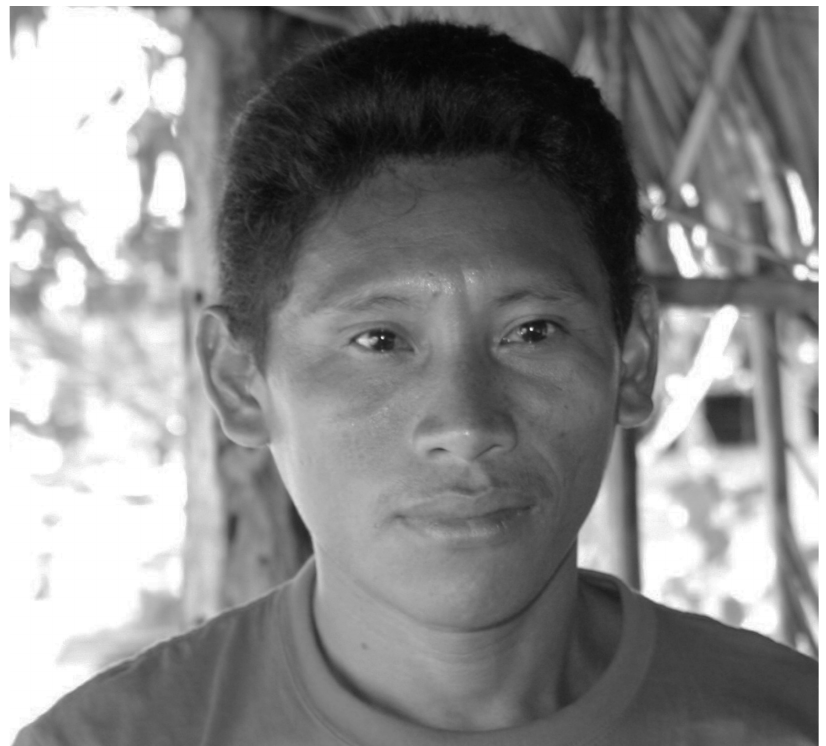
Figure 2. Wilmer Torres tells the story of losing two of his children to the strange disease; Mukoboina, Venezuela, 2008. Photograph by Charles L.